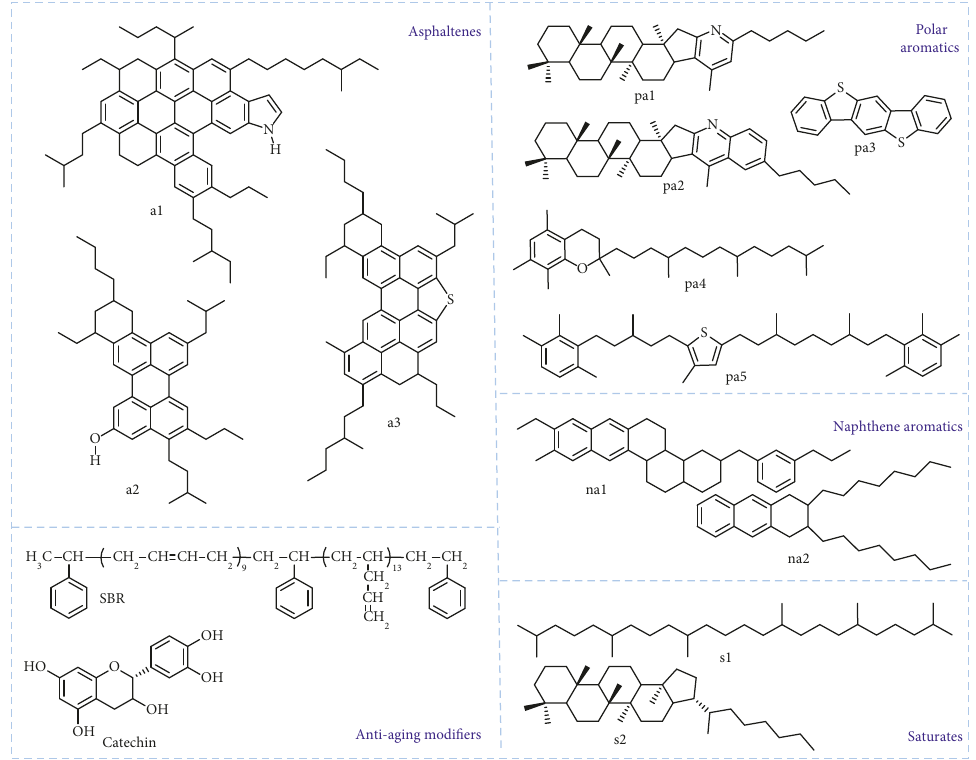
Figure 1: Representative molecules of asphalt components and antiaging